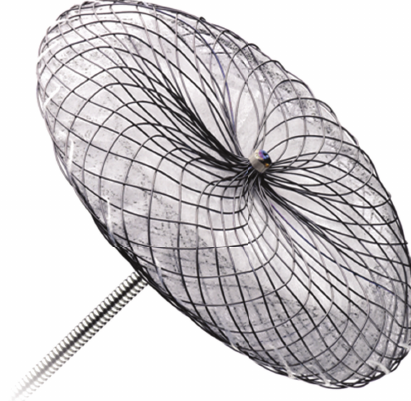
Figure 1: AMPLATZER septal occluder. (AMPLATZER and St. Jude Medical, Inc. Reprinted with permission of St. Jude Medical, © 2011. All rights